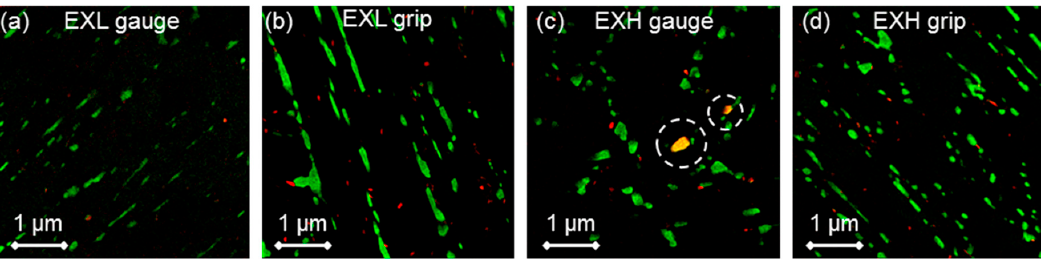
Figure 16. Composite Cr (green) and V (red) elemental maps obtained from Energy-Filtered Transmission SEM (EFTEM) of ( a , b ) EXL and ( c , d ) EXH gauge and grip regions, respectively. Z phase particles are indicated by the circle outlines in ( c ).